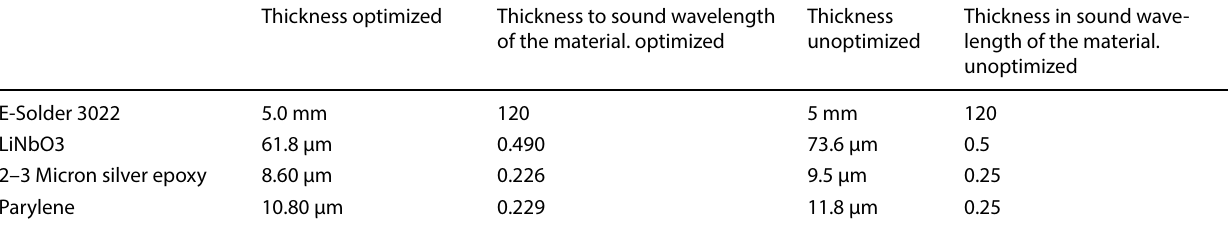
Fig. 3 The electrical imped- ance (blue) and its phase (red) of the probe with theoretical thicknesses resulting from the KLM model